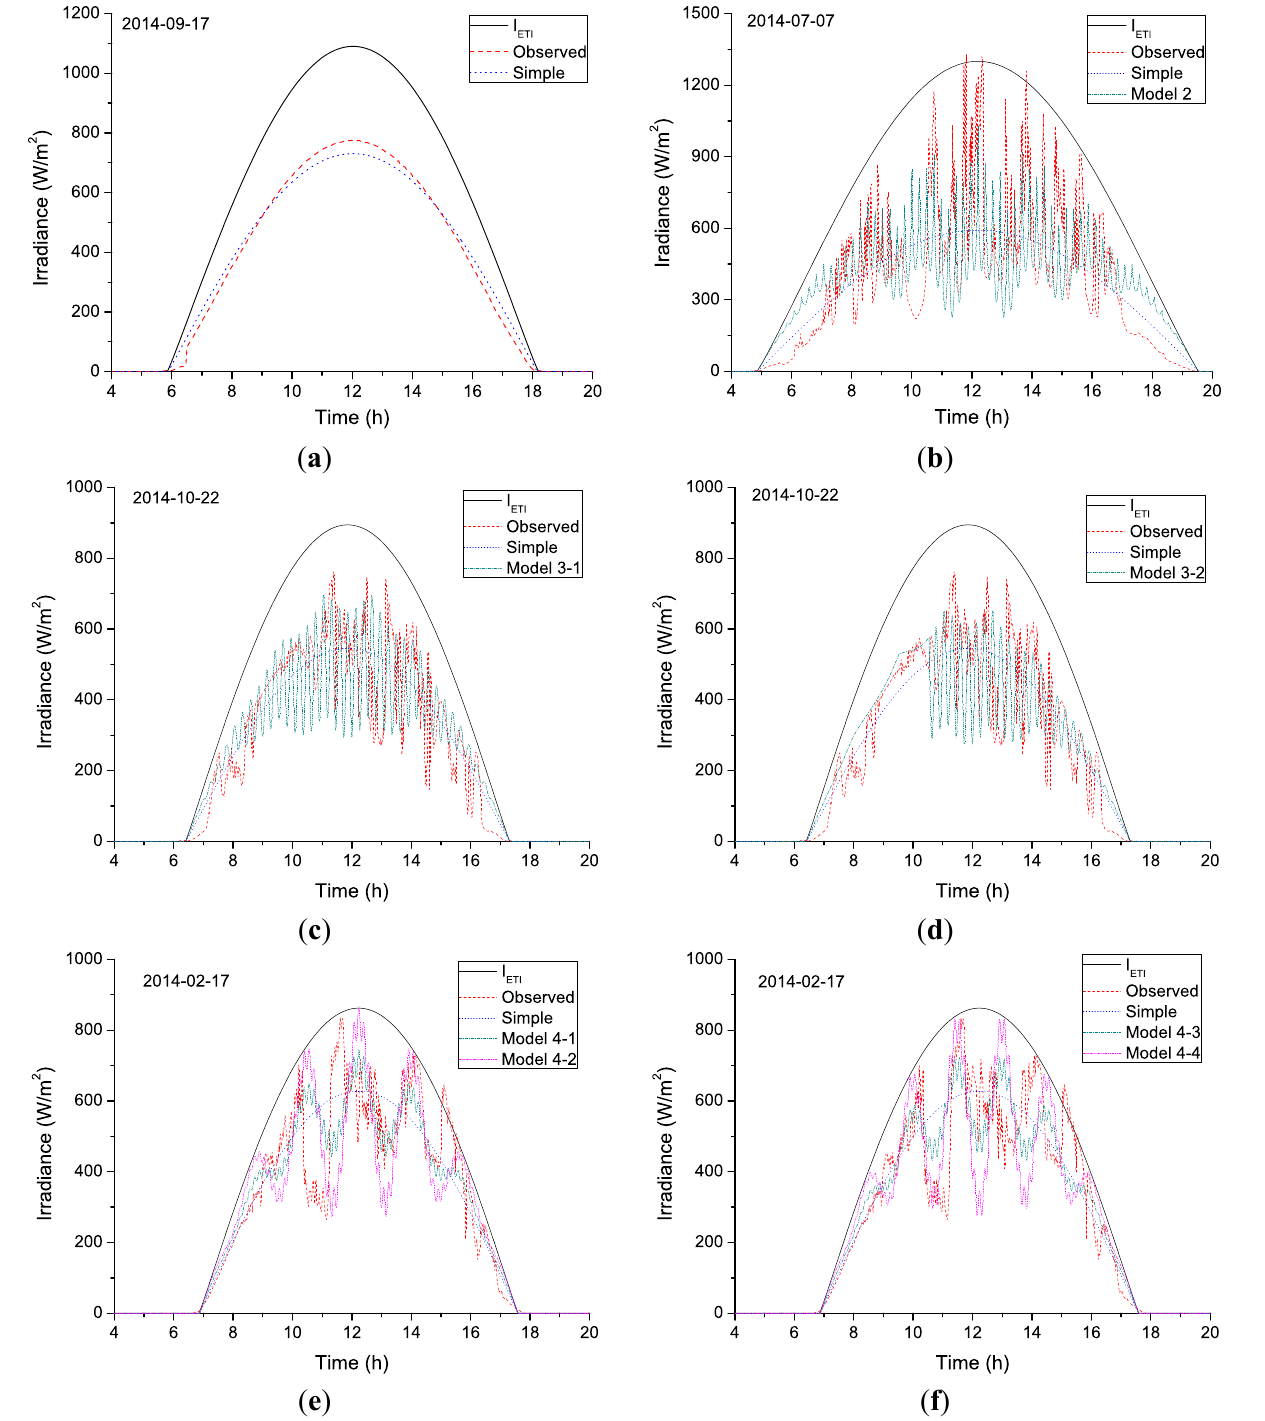
Figure 2. Solar radiation distributions for the actual weather data, the simple sky model and the proposed model as shown in Table 2. Data ( a – d ) observed in Anatolia-Rancho Cordova, California (latitude: 38.546° N; longitude: 121.24° W; elevation: 51 m; PST) [20]. Data ( e , f ) observed in Golden, Colorado (latitude: 39.742° N; longitude: 105.18° W; elevation: 1828.8 m; MST)